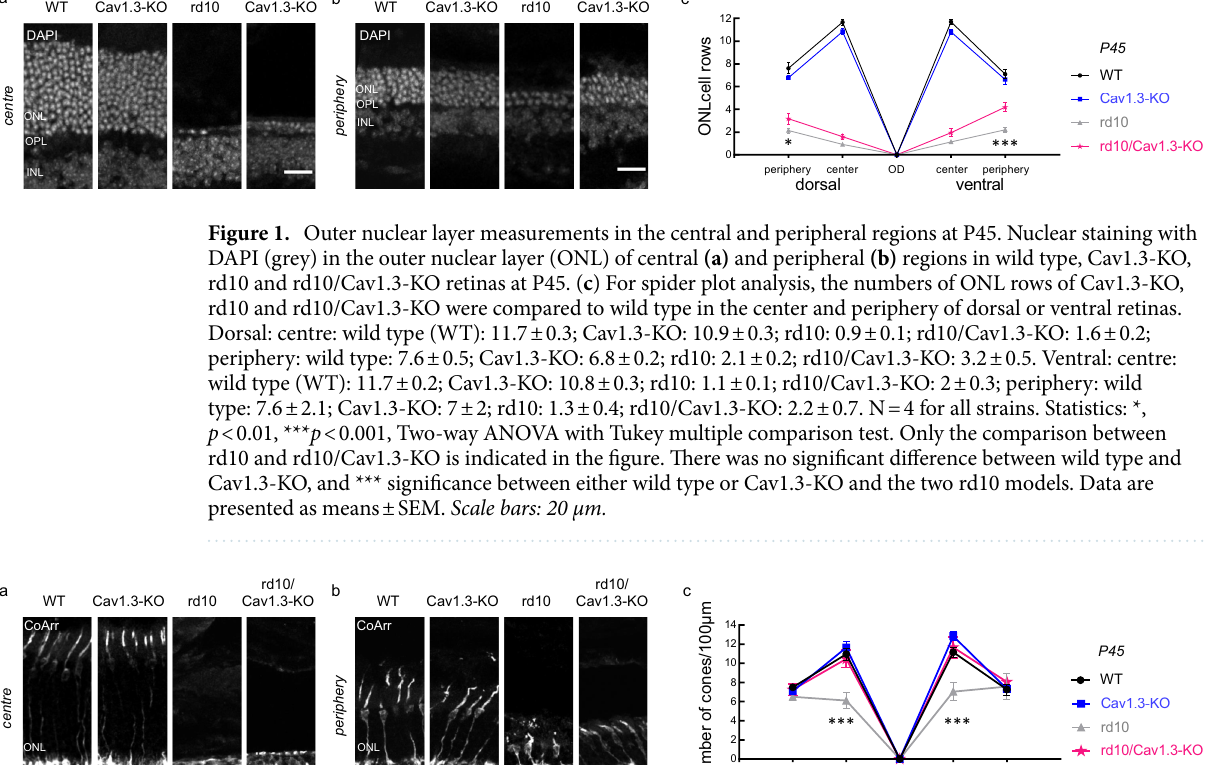
Cav1.3 deficiency delays photoreceptor degeneration in rd10 mice. First, we investigated changes in the thickness of the outer nuclear layer (ONL) at P45, the peak of cone cell death that follows the peak degeneration of rods. Because the rd10 mutation primarily affects rod photoreceptors (making up 97% of all photoreceptors in the mouse retina 37 , and the fact that the degeneration wave follows a centre-to-periphery gradient 7 , we counted the cell rows in the central and peripheral ONL of rd10 and rd10/Cav1.3-KO retinas and compared them with Cav1.3-KO and wild type (Fig. 1). In dorsal and ventral regions, rd10 and rd10/Cav1.3-KO mice showed a significant reduction of cell nuclei in the ONL compared to wild type and Cav1.3-KO controls (Fig. 1c). In the central retina, the two rd10 models showed no statistical difference in the number of photorecep- tor rows while we observed a slight but significant reduction in Cav1.3-KO mice compared to wild type (Fig. 1b). In the periphery, instead, where WT and Cav1.3-KO have comparable ONL width, we detected significantly more cell rows in the rd10/Cav1.3-KO retina than in rd10 (Fig. 1c). We therefore explain the difference in ONL thickness in the centre and periphery as the consequence of a delayed degeneration of peripheral photoreceptors (mostly rods) in the absence of Cav1.3 LTCCs in the rd10 retina. Cone cell degeneration was delayed in rd10/Cav1.3‑KO mice. At P45, when only a single layer of photoreceptors is left in rd10 mice, we also quantified cones and compared their morphology in all four mouse strains (Fig. 2). Similar to previous studies 38 , we observed a significant reduction of cones in the dorsal and ventral central retina of rd10 mice (Fig. 2c). Rd10/Cav1.3-KO retinas, instead, showed a comparable number of cones in wild type and Cav1.3-KO controls (Fig. 2c). In the periphery, the number of cones was unchanged in all four mouse strains (Fig. 2c). While Cav1.3-KO cones preserved their typical morphology with a long outer segment (OS), cell body, axon and pedicle structures, rd10 and rd10/Cav1.3-KO cones were severely affected (Fig. 3). Rd10 cones mostly